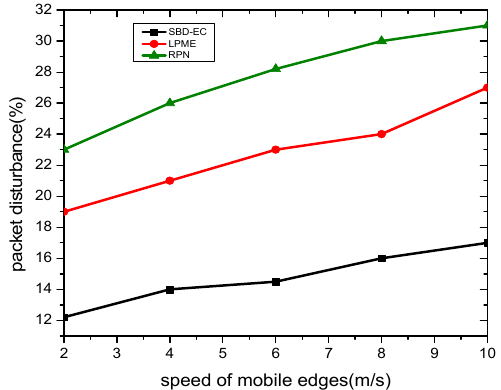
Figure 8. Packet disturbance and mobility.